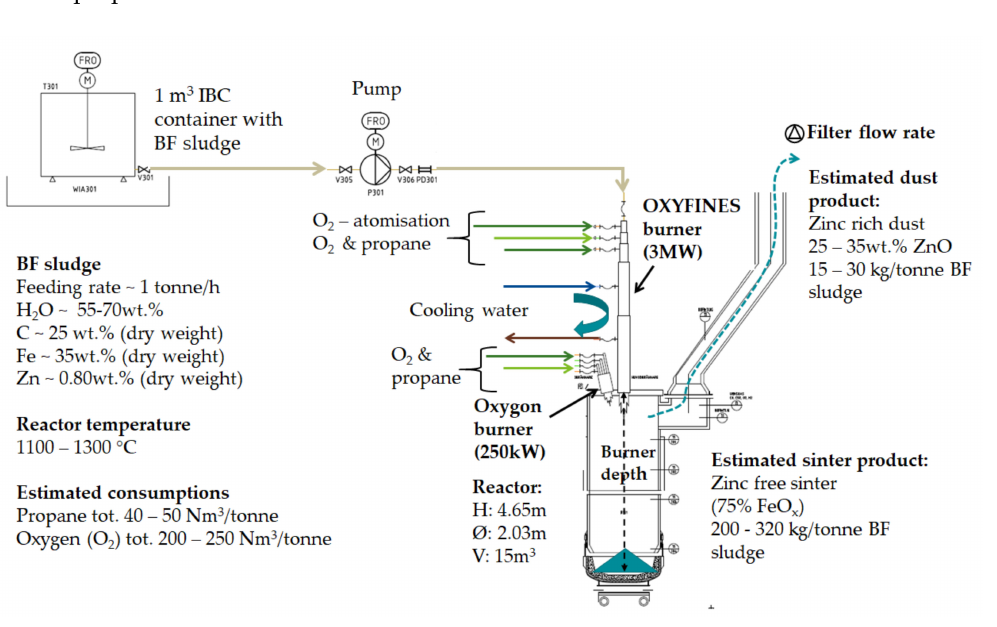
Figure 2. The principle of OXYFINES pilot set-up for BF sludge upgrading and expected